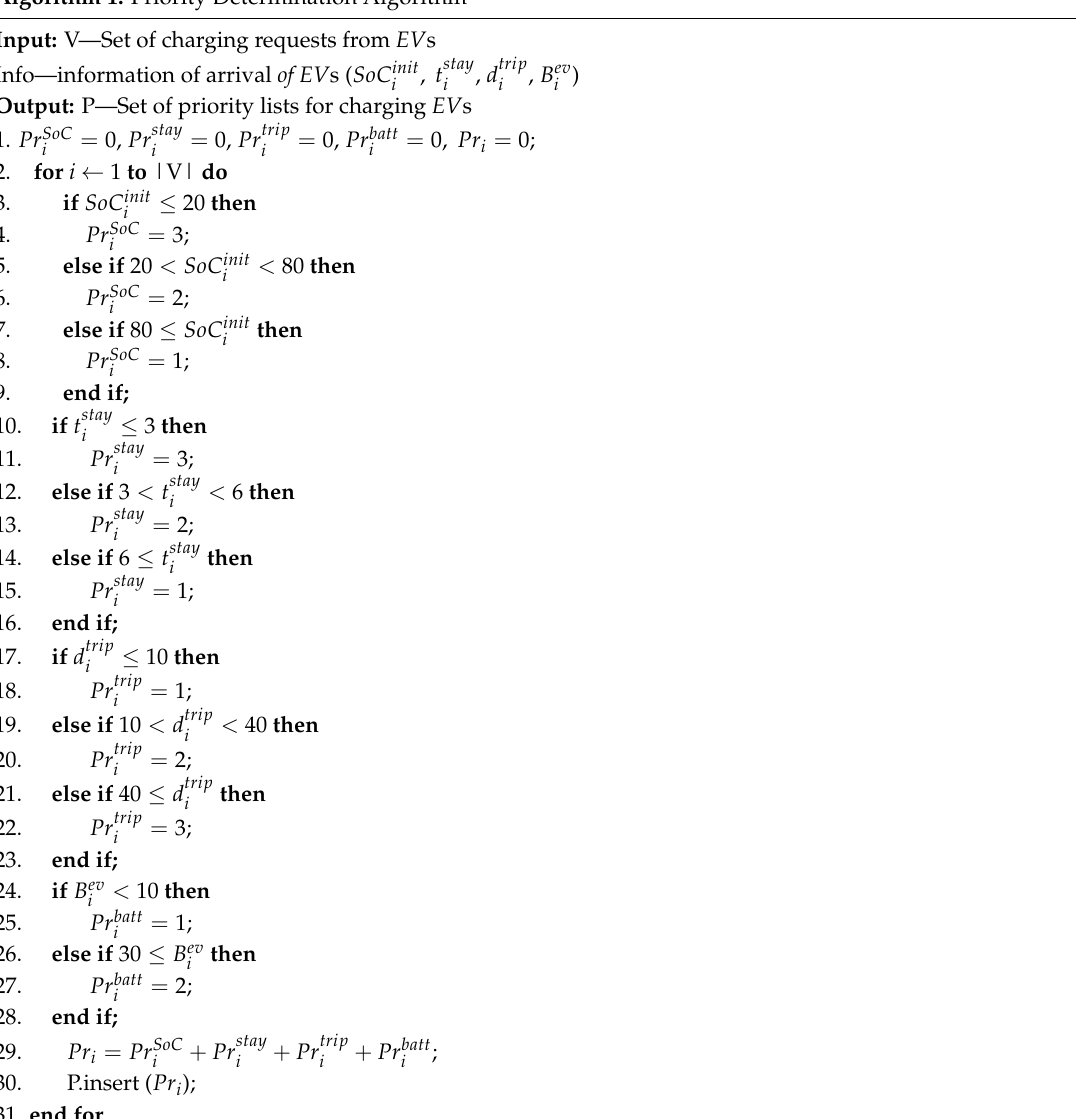
Algorithm 1. Priority Determination